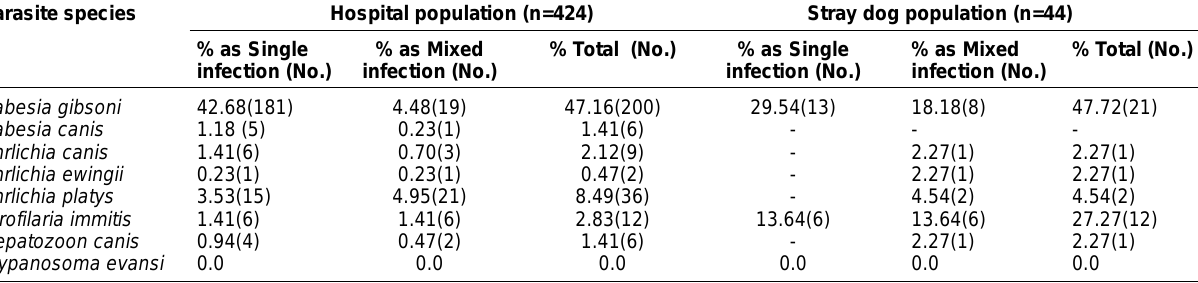
Table-2. Species-wise prevalence of haemoparasite infection in hospital and stray dog populations Parasite